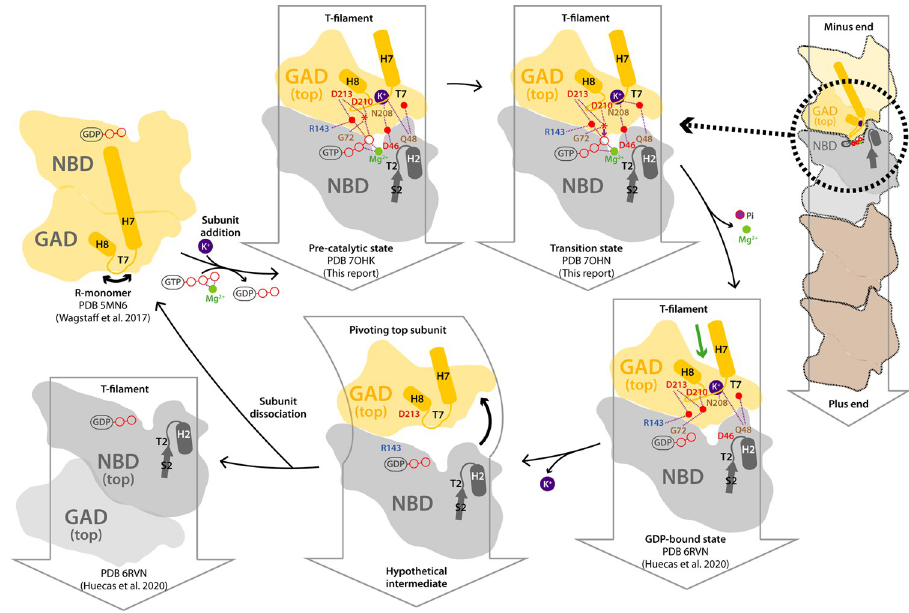
Fig 6. Model for FtsZ filament dynamics and catalytic assembly cycle. On the right, schematic FtsZ filament with top and second-top subunits in yellow and gray, respectively. The dotted black circle defines the area represented in the remaining cartoons of the filament assembly interface, where only the GAD of the top subunit and the NBD of second-top subunit are represented. Structural elements and relevant residues are labeled, while Mg 2+ , K + , and water are represented as green, purple, and red spheres, respectively. A red star indicates the catalytic water, while H-bonds are shown as purple dashed lines. A green arrow indicates the cleft for PC190723 binding.